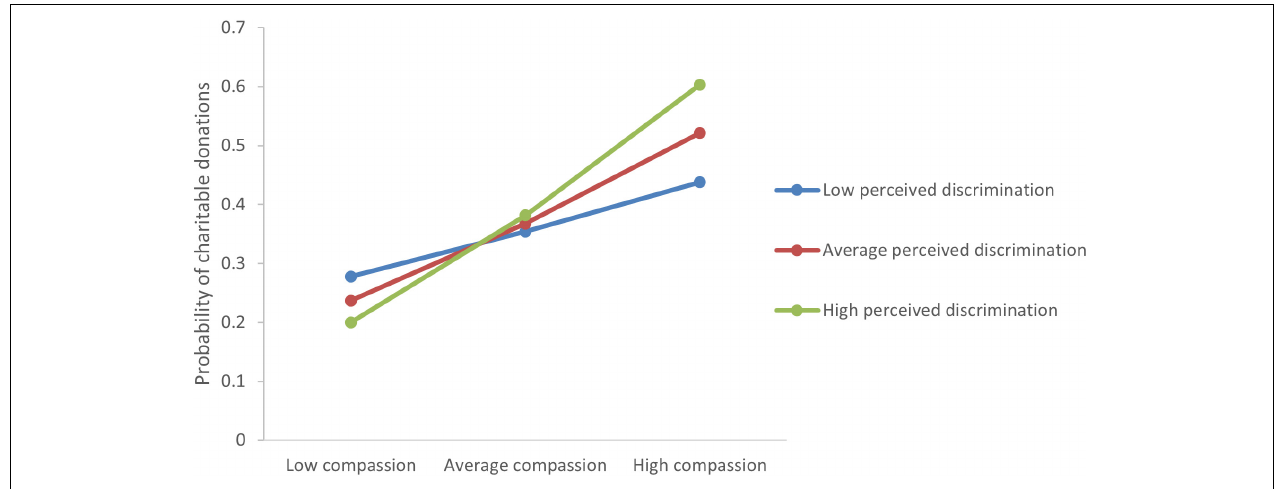
FIGURE 1 | Perceived discrimination enhances the positive effect of compassion on charitable